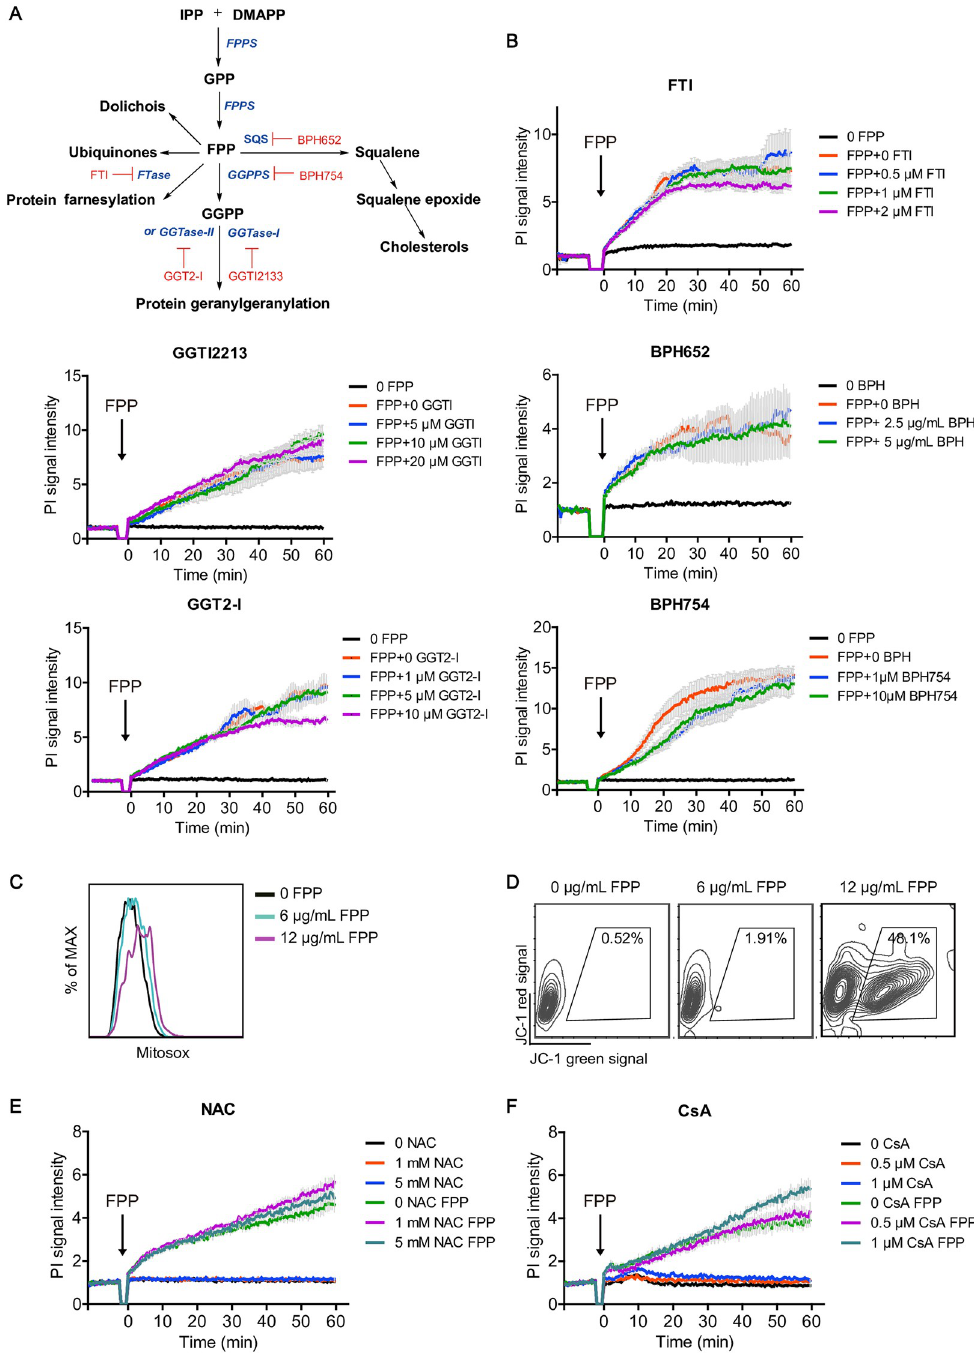
Fig 3. FPP downstream metabolic pathways and conventional cell death pathways are not required in FPP-induced cell death. (A) Schematic view of FPP upstream and downstream metabolic pathway and their inhibitors. Enzymes are in blue, and inhibitors are in red. (B) Effects of FPP downstream pathway inhibitors on FPP-induced cell death. Black arrows indicate the time points at which different reagents were added. Bars denote mean ± SEM (SEM in gray). (C) Intracellular ROS indicated with mitosox stain after FPP treatment. (D) Mitochondrial potential decrease indicated with jc-1 stain after FPP treatment. (E, F) Effects of ROS scavenger NAC (E) and mitochondrial permeability inhibitor CsA (F) on FPP- induced cell death. Each treatment has 3 to 4 replicates. Bars denote mean ± SEM (SEM in gray). Data are representative of at least 2 independent experiments in (B) to (E). No significant differences between the inhibitor treatment groups and the no inhibitor treatment group have been observed in (B), (E), and (F) ( p > 0.05). Two-way ANOVA analysis is used.